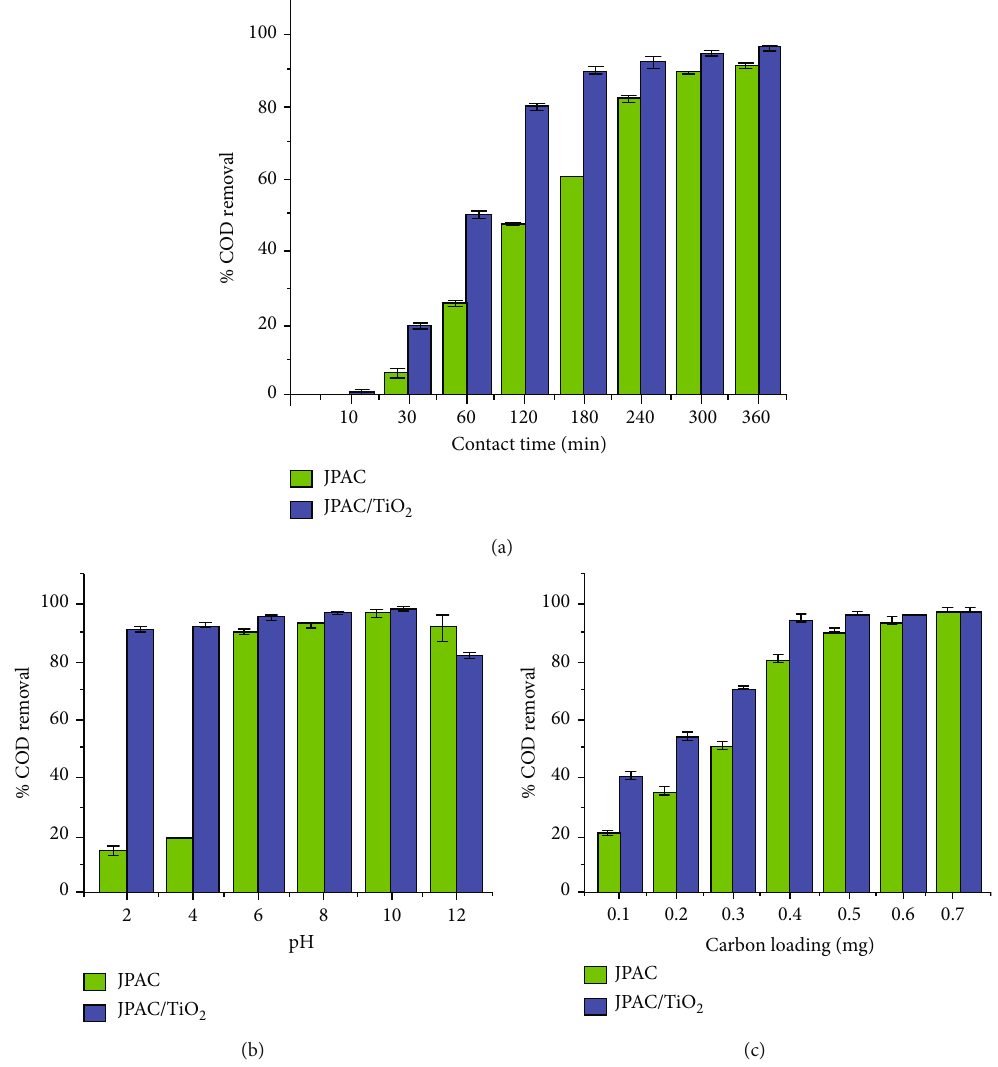
Figure 16: E ff ect of (a) contact time, (b) pH, and (c) carbon loading on COD removal using JPAC and JPAC/TiO ( adsorbent dose = 0 : 5 g, COD C i = 4000 mg/L, solution pH, T = 303 K, and contacttime = 4 h). Table 8: Typical parameters of tannery e ffl uent (Red 2BN) before and after adsorption. Constituents present in tannery Parameters e ffl uent (Red 2BN) before adsorption pH Suspended solids (mg/L)